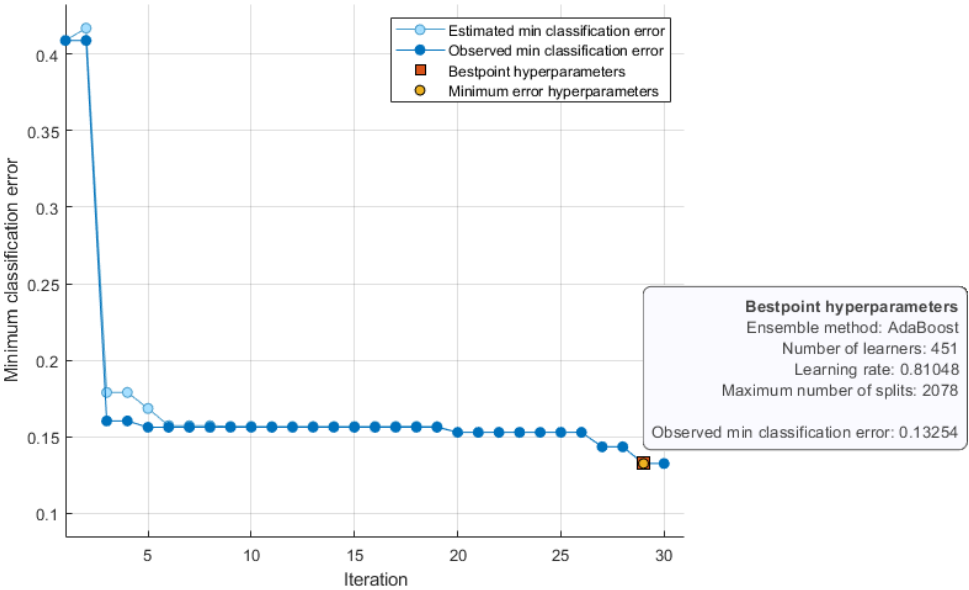
Figure 4. Hyperparameter optimizing